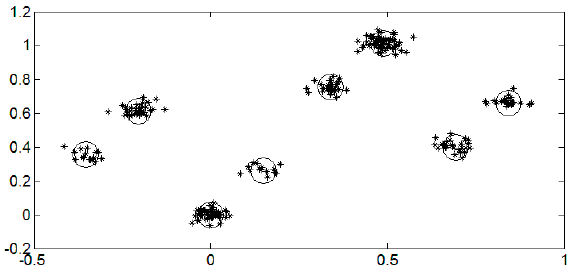
Figure 3. A constellation for three collided tags in an IQ plane under SNR = 20 dB.